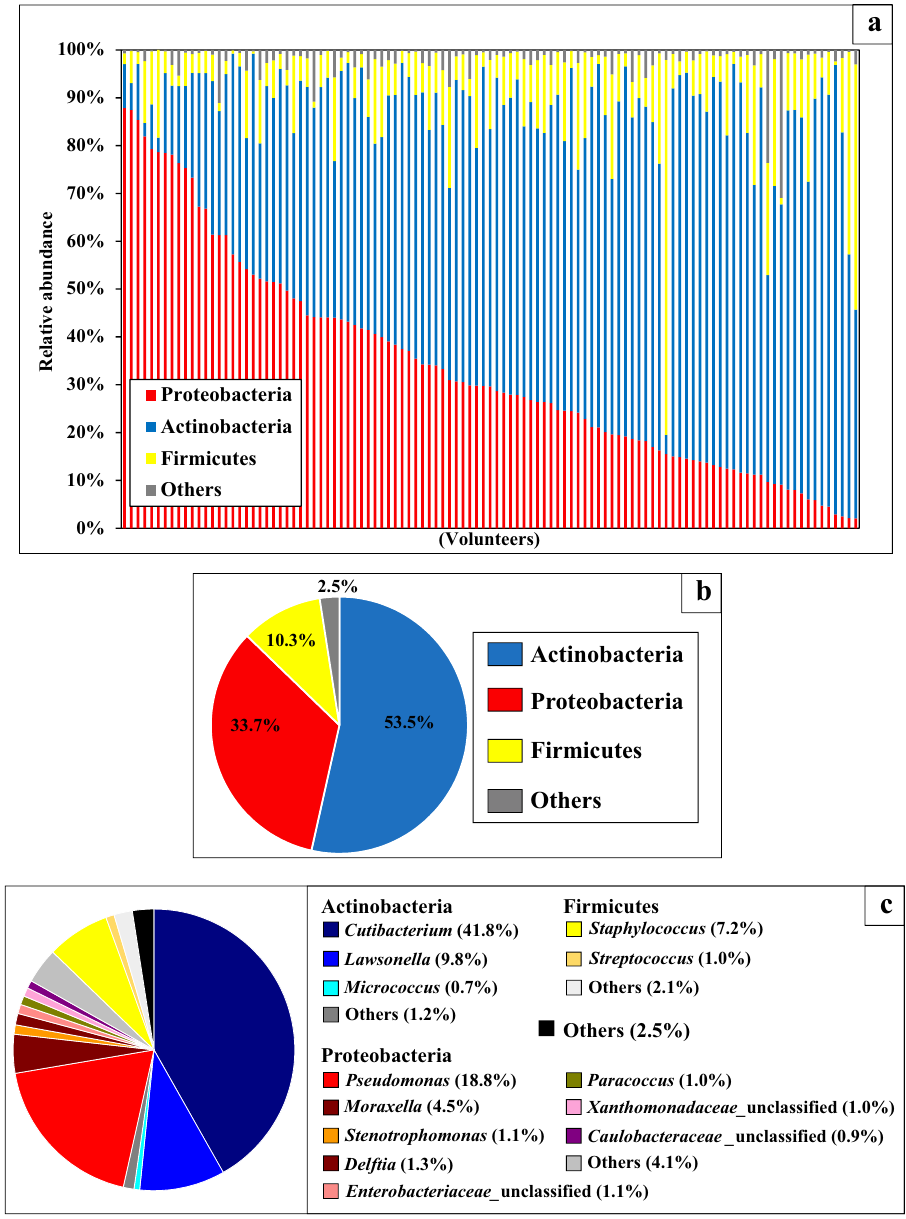
Figure 2. ( a ) The relative abundance of major phyla in the bacterial community structure on each volunteer of scalp hair shaft. Volunteers were arranged according to relative abundance of Proteobacteria. ( b ) The average relative abundances of the major phyla in bacterial community structure on scalp hair shaft. ( c ) The average relative abundances of the major genera in bacterial community structure on scalp hair